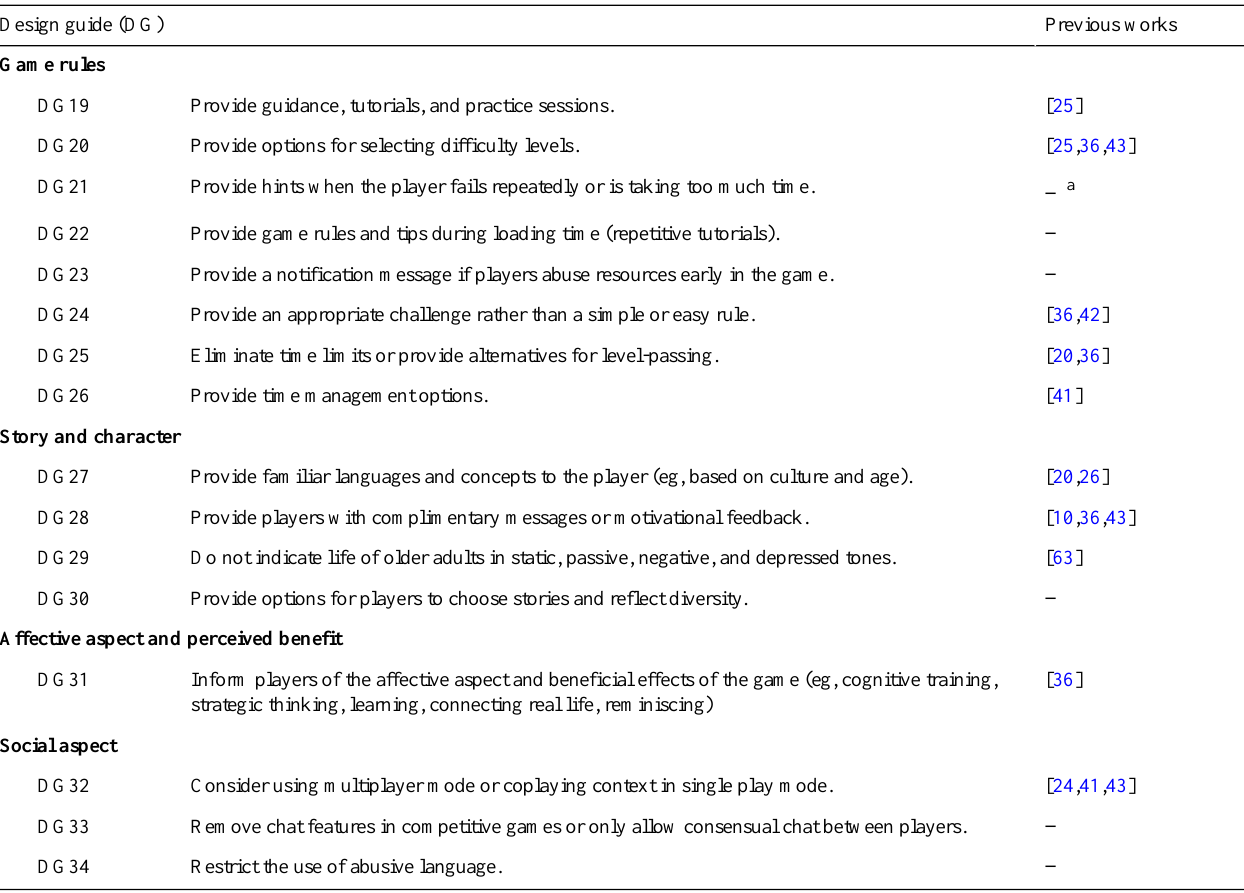
Table 6. Mobile game design guides on psychological and socioemotional